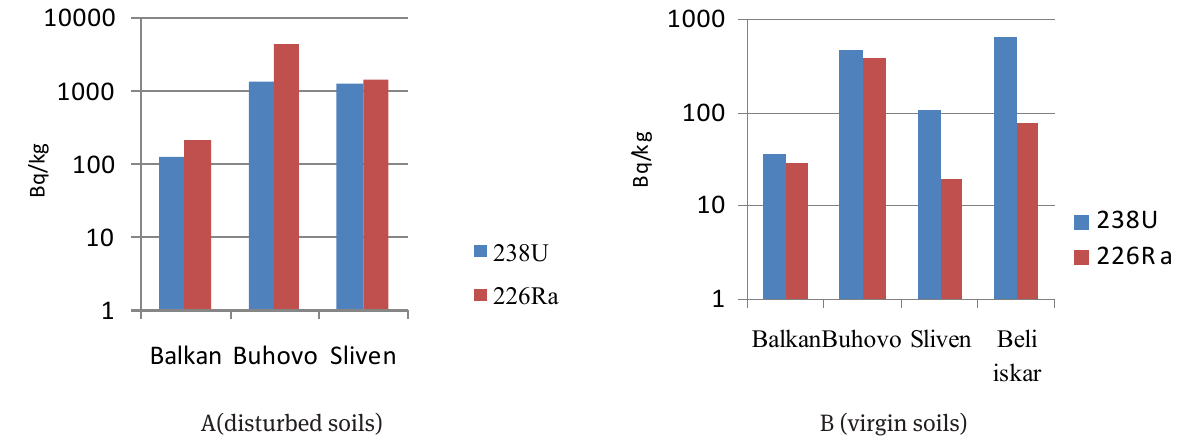
Figure 5: 238 U and 226 Ra concentrations in disturbed (a) and virgin (b) soils from areas with former uranium mining facilities [Bq kg -1